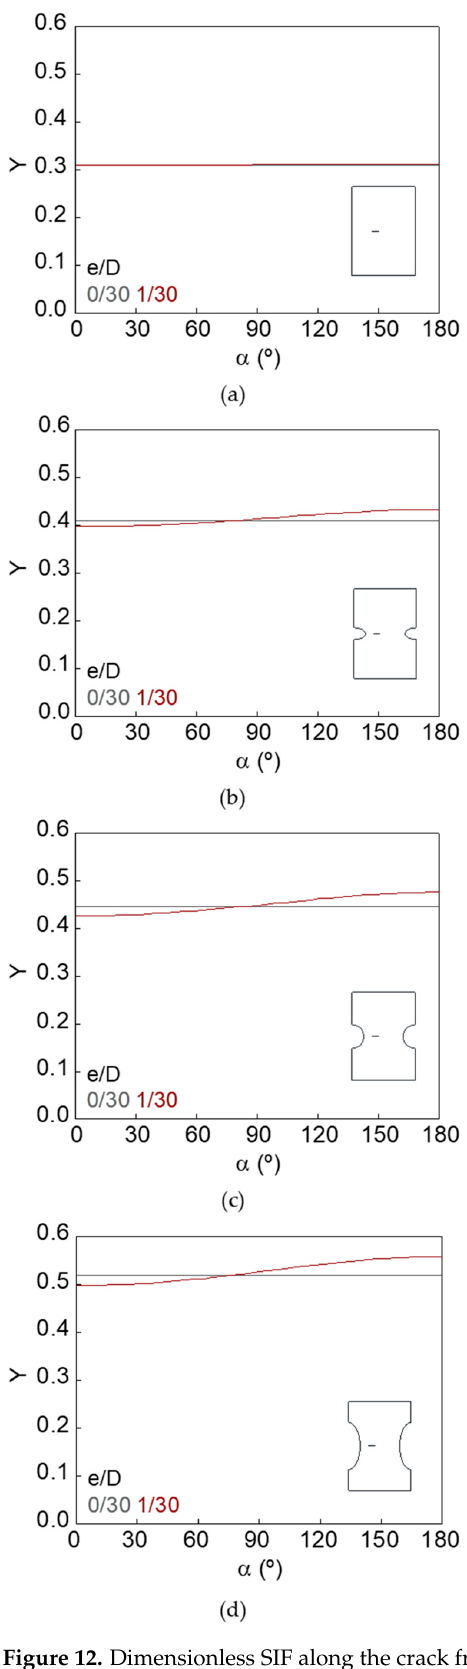
Figure 12. Dimensionless SIF along the crack front, d / D = 13/30: ( a ) smooth bar; ( b ) sharp notched bar; ( c ) circular notched bar; ( d ) blunt notched bar.